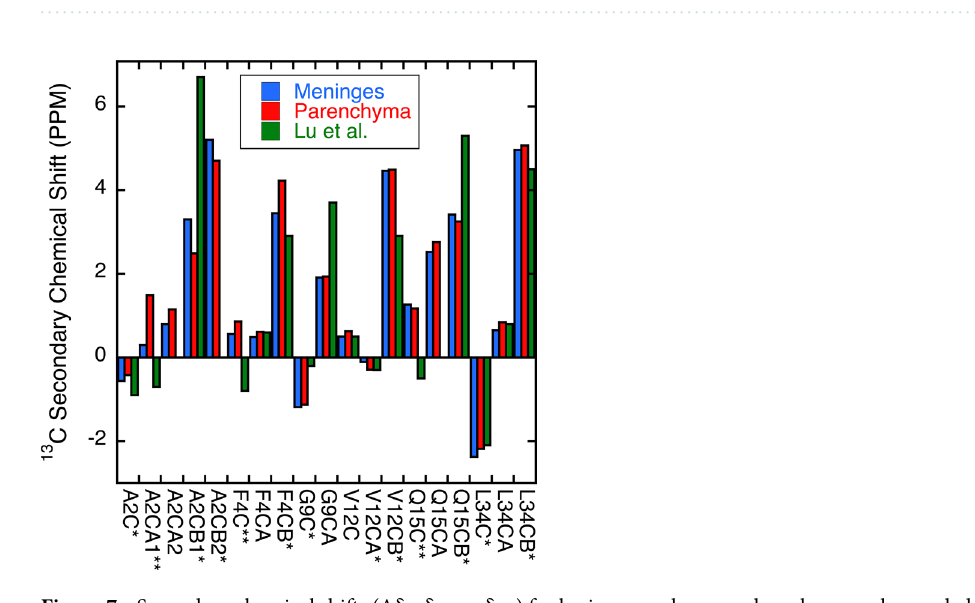
Figure 7. Secondary chemical shifts (Δδ = δ fibril – δ coil ) for brain parenchyma and cerebrovascular-seeded fibrils. Also shown in the figure are values for secondary chemical shifts in brain-seeded Aβ40 samples reported by Lu et al. 3 . Values represent the mean chemical shifts for the spectra of Aβ40 fibrils seeded by material from Patients 1, 2, and 3. * indicates that all three samples gave chemical shifts typical of β-sheets; ** indicates one or two of the samples gave a value typical of β-sheets, i.e., negative for 13 CO and 13 Cα, positive for 13 Cβ. (Note that for Gly residues in general 13 Cα secondary shifts are not correlated with secondary structure 46,47